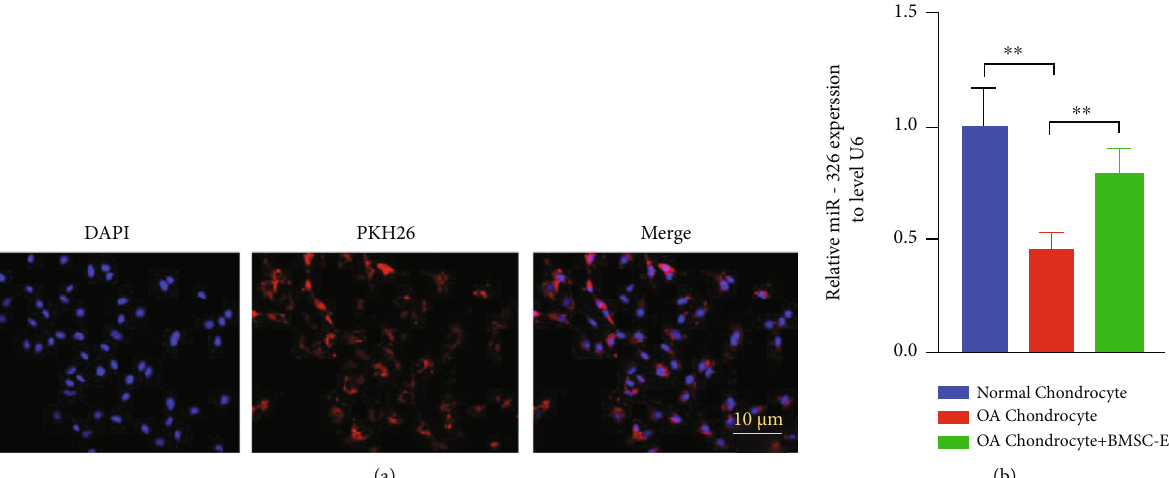
Figure 3: BMSC-Exos delivered miR-326 to OA chondrocytes. (a) PKH26 markers showed BMSC-Exos uptake by chondrocytes; (b) incubation of BMSC-Exos reversed OA-induced reduction of miR-326 levels in chondrocytes; ∗∗ P < 0 : 01